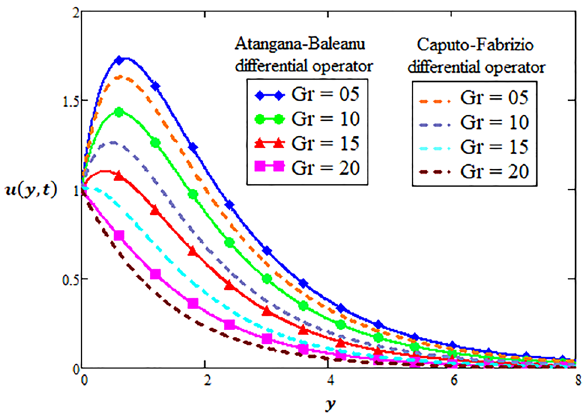
Figure 5. Variation of Grashof number for two-dimensional velocity profile through AB-differential operator verses CF-differential operator.